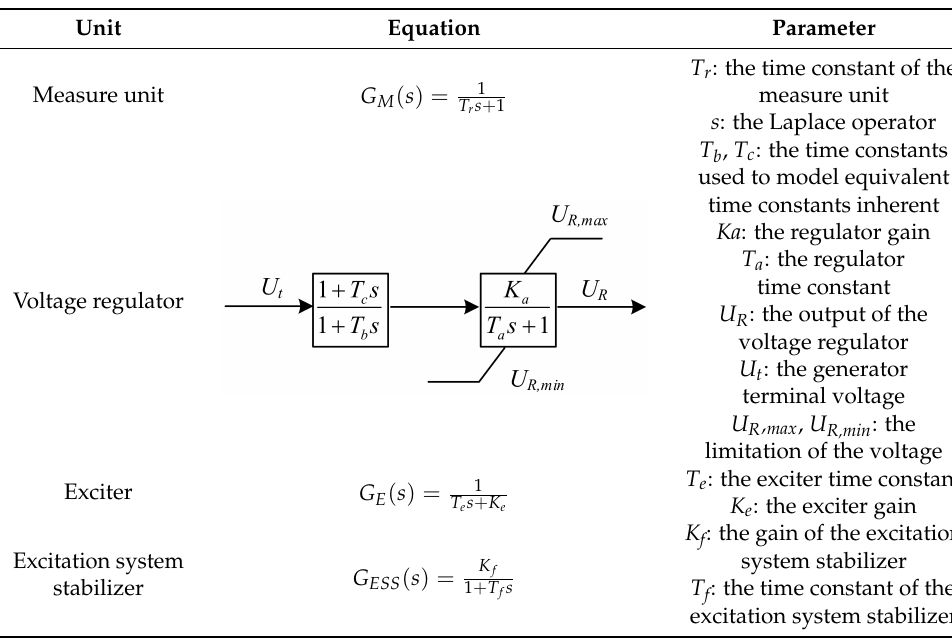
Figure 3. A typical excitation system configuration. U t is the generator terminal voltage. U ref is the reference voltage. U R is the output of the voltage regulator. E f is the excitation voltage. r f is the excitation winding resistance of generator. x ad is the inductance coefficient of the d -axis armature reaction. U f is the output of the excitation system stabilizer. U s is the output of the power system stabilizer. PSS stands for the power system stabilizer. Table 1. The excitation system model of each